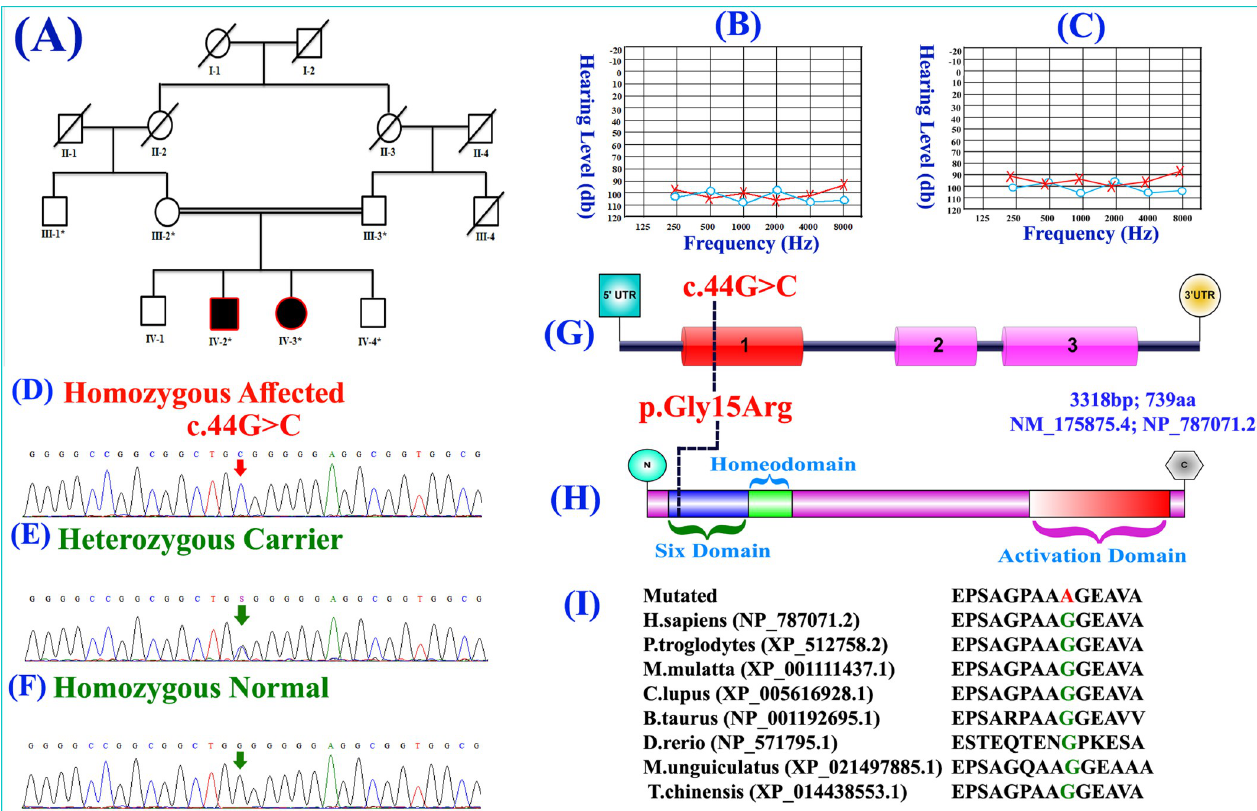
Fig 1. ( A ) Autosomal recessive inheritance pattern family pedigree. White circles and squares represent unaffected males and females, filled (black) circles and squares represent affected individuals, while crossed lines symbols are the deceased individuals. The consanguineous union is represented by double lines between symbols. Individuals with asterisks are the ones available for the present study. ( B, C ) Air conduction audiograms of affected individuals IV-2, and IV- 3. Pure-tone audiometry was conducted between 250 and 8,000 Hz and red crosses, right ear; blue circles, left ear. Age at the time of audiometry (IV-2, 18 years; IV-3, 23 years). Individuals with the impairment have profound hearing loss at all frequencies. ( D ) Sanger sequencing electrograms showing co-segregation of the pathogenic missense variant (c.44G > C) identified in SIX5 gene in homozygous affected, ( E ) heterozygous carrier and ( F ) homozygous normal individuals of the family. (G, H) Schematic representation of SIX5 gene and protein. The text in red denotes the variant discovered in this analysis, which is located in exon 1 and the SIX domain (SD). The exons and introns have not been drawn to proportion. (I) Partial amino acid sequence of the SIX5 protein showing substitution of Glycine amino acid into Arginine amino acid and conservation of Glycine amino acid across different species.